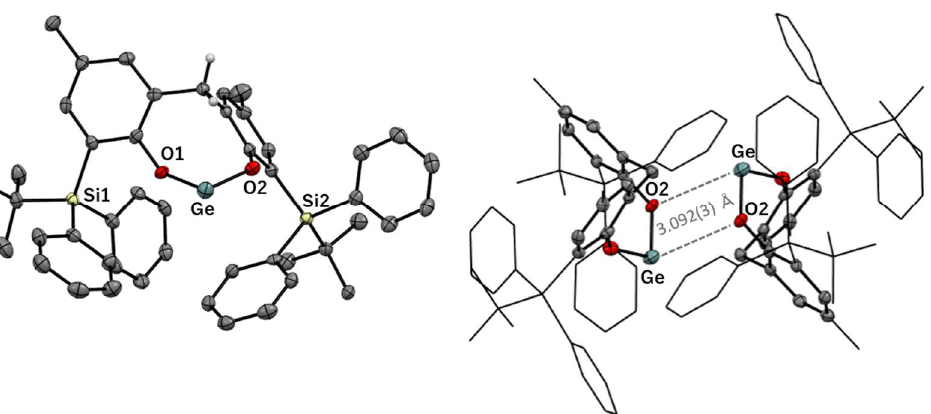
Figure 1. Solid-state structures of 3a with thermal ellipsoid plots at 50% probability. All hydrogen atoms except for those of the methylene in the left figure are omitted for clarity. Left : monomeric structure. Right : two closest germylene units in the packing structure. The Si t BuPh 2 and Me groups are shown in wireframe.